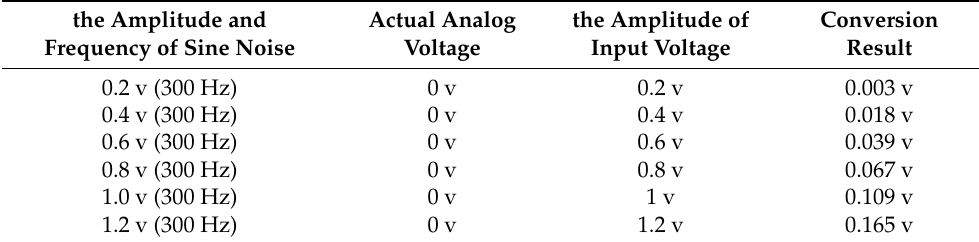
Table 2. The conversion results of the 0 V analog voltage with the sine noises. the Amplitude